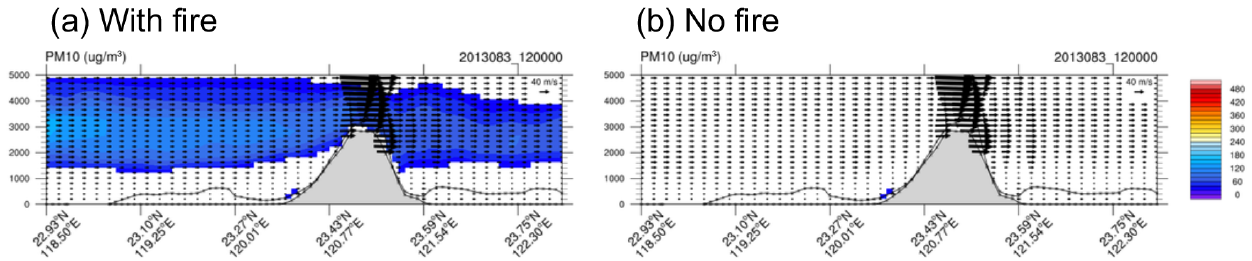
Figure 10. Vertical cross-sectional AA’ (Fig. 1b) profile for PM 10 (contour), wind in x – z direction (vector), PBLH (dotted lines) and terrain height (gray shade) on 24 March at 20:00LST (a) with fire and (b) with no fire.